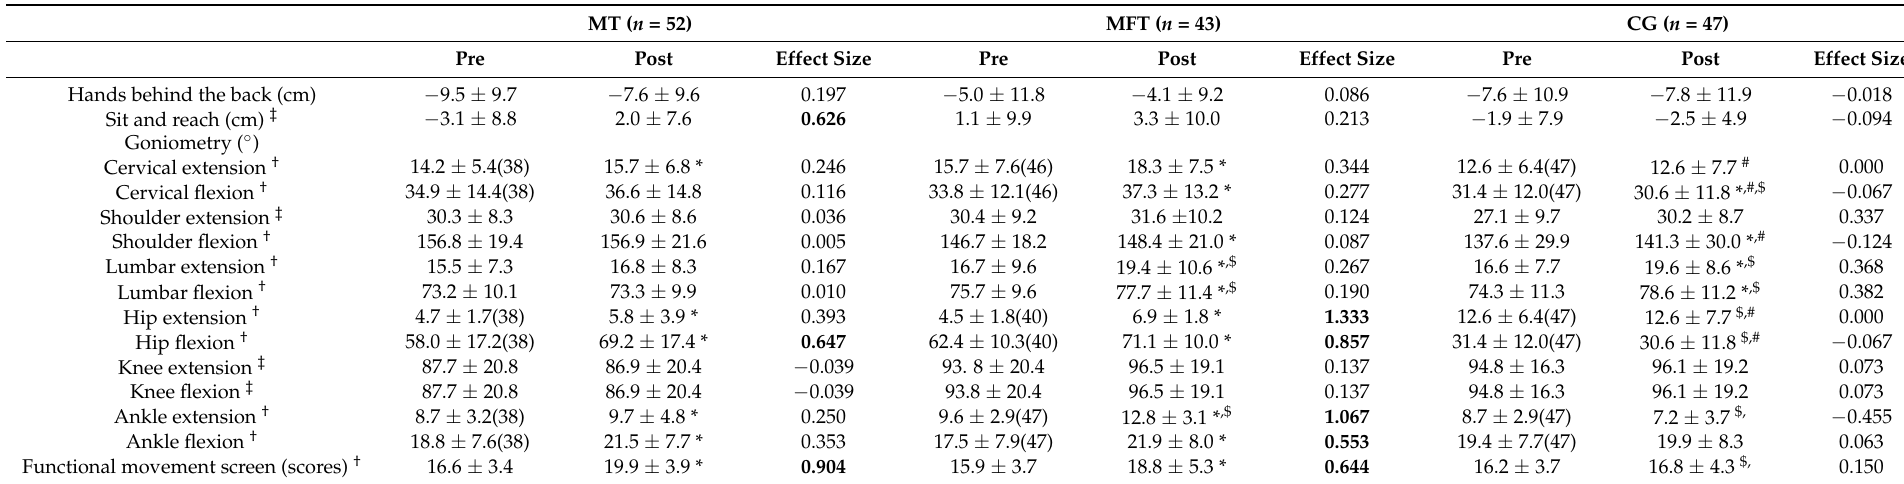
Table 3. Flexibility and movement quality at the pre and post experimental period